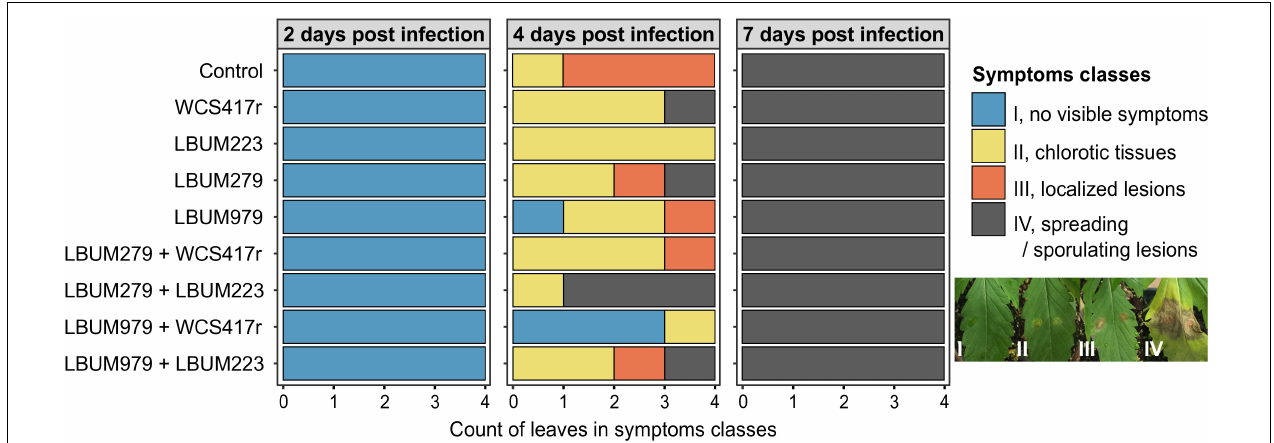
FIGURE 1 | Symptoms severity on cannabis leaves 2, 4, and 7 days after infection by B. cinerea . Cannabis seedlings were primed with single-bacteria root treatments ( Pseudomonas strains WCS417r and LBUM223; Bacillus strains LBUM279 and LBUM979), or consortium root treatments (LBUM279 + WCS417r, LBUM279 + LBUM223, LBUM979 + WCS417r, LBUM979 + LBUM223), or mock-primed with water (control). After one week, plants were infected with B. cinerea (2 droplets containing 10 3 conidia/mL) and kept under high humidity for 2, 4, and 7 days. Symptoms were assigned into 4 severity classes: I, no visible symptoms (blue); II, chlorotic tissues forming a yellow halo (yellow); III, necrotic localized lesions smaller than the original droplets size (orange); IV, large spreading lesions with tissue maceration expanding beyond the original droplets and/or sporulating (gray). Stacked barplots represent the number of leaves assigned into each class per bacterial treatment, with 4 independent biological replicates at each harvest time (each leaf comes from a different plant). No statistically significant biocontrol protection was reported when comparing bacteria-treated plants to control plants, at each harvest time (Kruskal-Wallis rank sum test with Dunn pairwise comparisons and Benjamini-Hochberg correction, α =